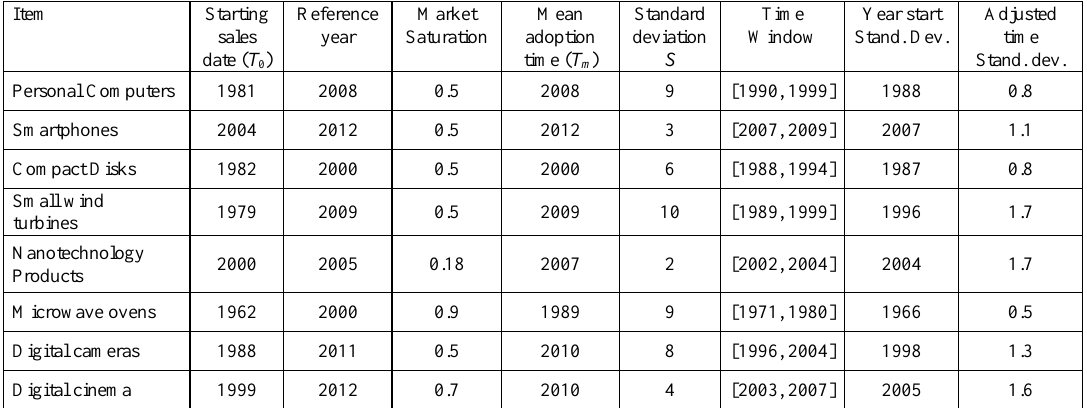
Table 1. Adoption cases with standards development